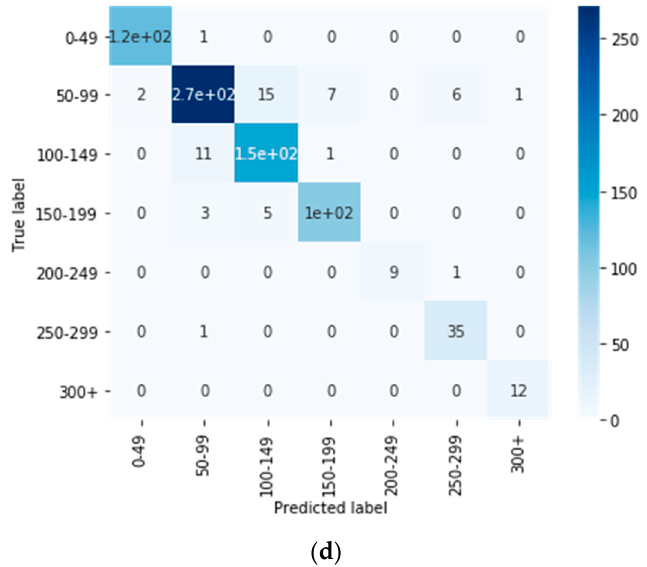
Figure 11. Confusion matrixes for ( a ) June, ( b ) July, ( c ) August, and ( d ) the whole dataset. The accuracy, precision, recall, and F1-score for all the classes and the whole data set were computed using the confusion matrix. The results as well as the number of instances per class for the test set are shown in Table 4. Accuracy is not a very good measure of performance when dealing with unbalanced datasets (like our case) because it counts the number of correct predictions regardless of the type of class. For this reason, it is biased towards the majority classes. Table 4. Comparison of accuracy and F1-score for all classes.